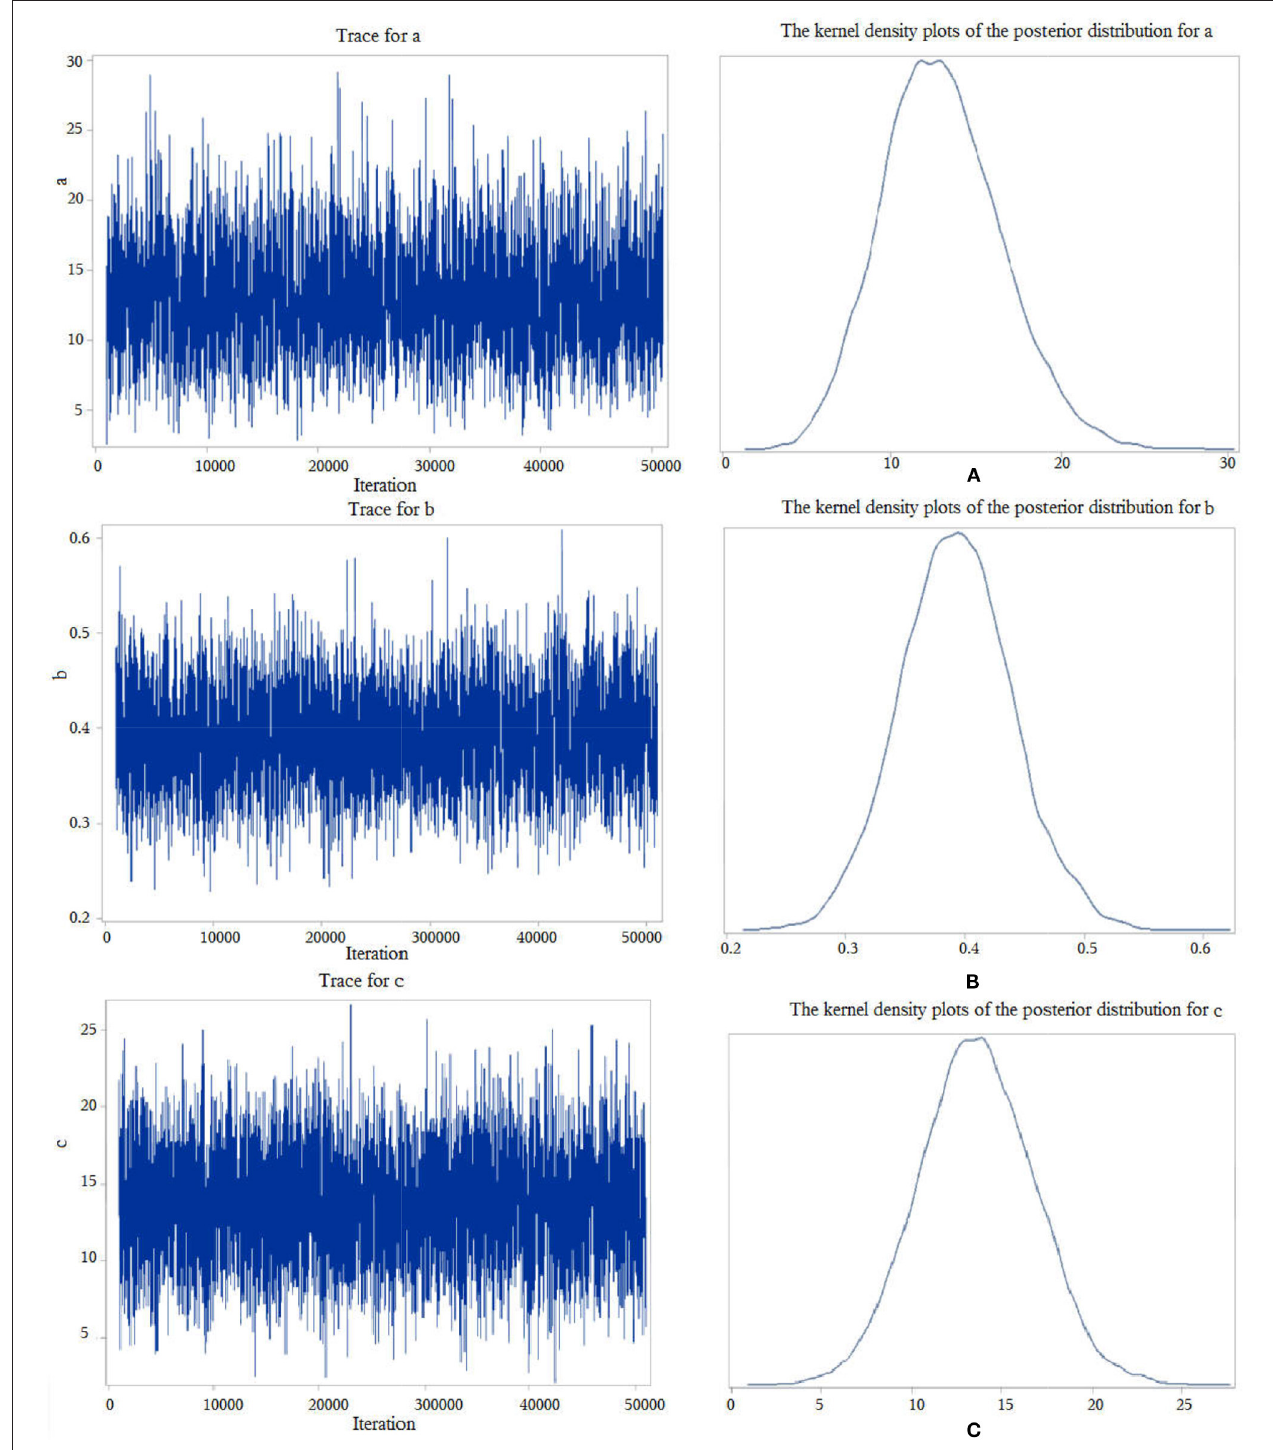
FIGURE 1 | Trace plots and kernel density plots of the posterior distribution for the parameters. “c” represents the total effect of the independent variable X on the dependent variable Y, “b” measures the relation between the mediator M and the dependent variable Y, adjusted for the independent variable X, and “a” measures the relation between X and